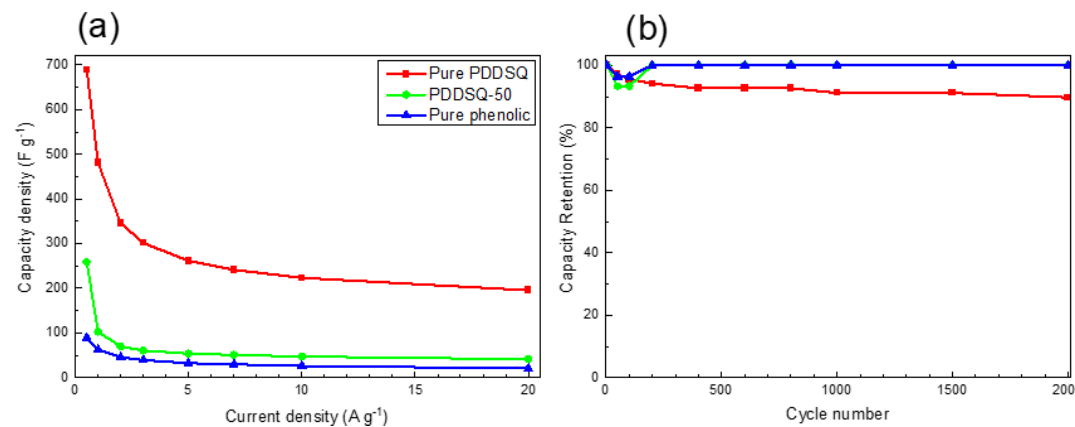
Figure 10. ( a ) specific capacitances measured at current densities from 0.5 to 10 A g − 1 and ( b ) cycling performance measured at a current density of 10 A g − 1 after 2000 cycles for the carbon / DDSQ hybrids derived from pure phenolic, PDDSQ-50, and pure PDDSQ.